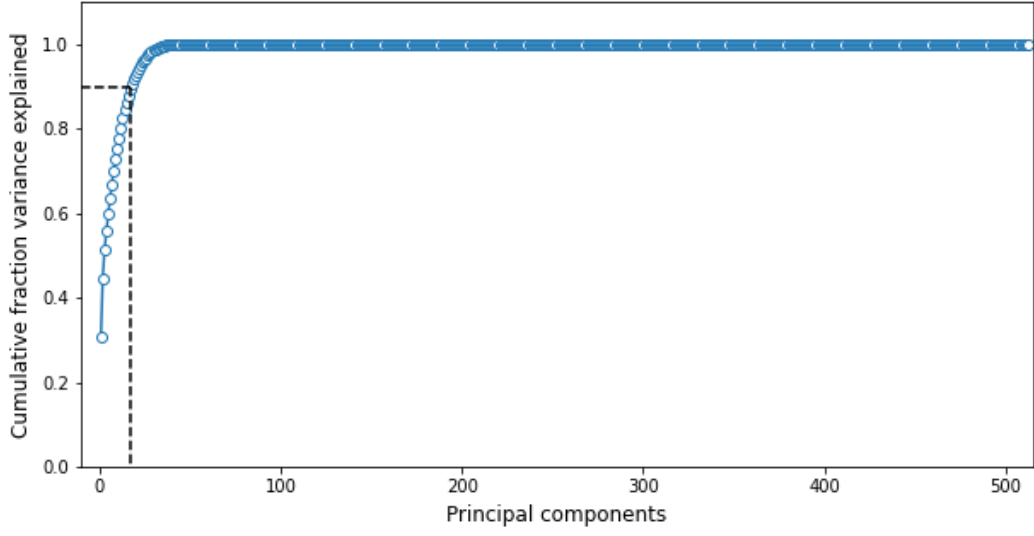
Figure 14. Distance plots for training the CNN in Method II, with a window length of 150 time steps: ( a ) original time series; and ( b ) surrogate time series. Table 3. CNN training parameters during contrast-based learning for Method II.